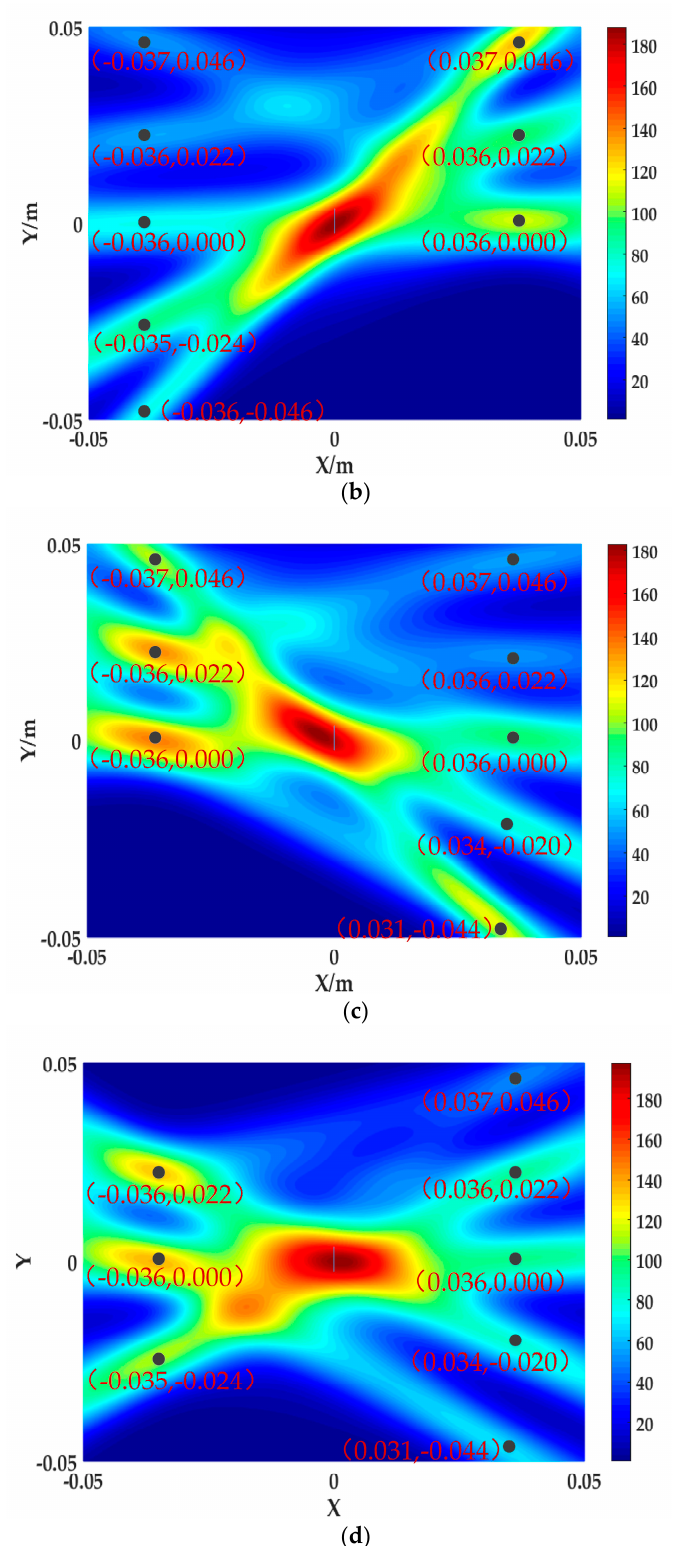
Figure 11. Positioning results when the excitation and reception probes are arranged differently: ( a ) Excitation1–4&Reception1–5; ( b ) Excitation1–3&Reception1–5; ( c ) Excitation1–5&Reception1–3; ( d ) Excitation1–5&Reception2–4.